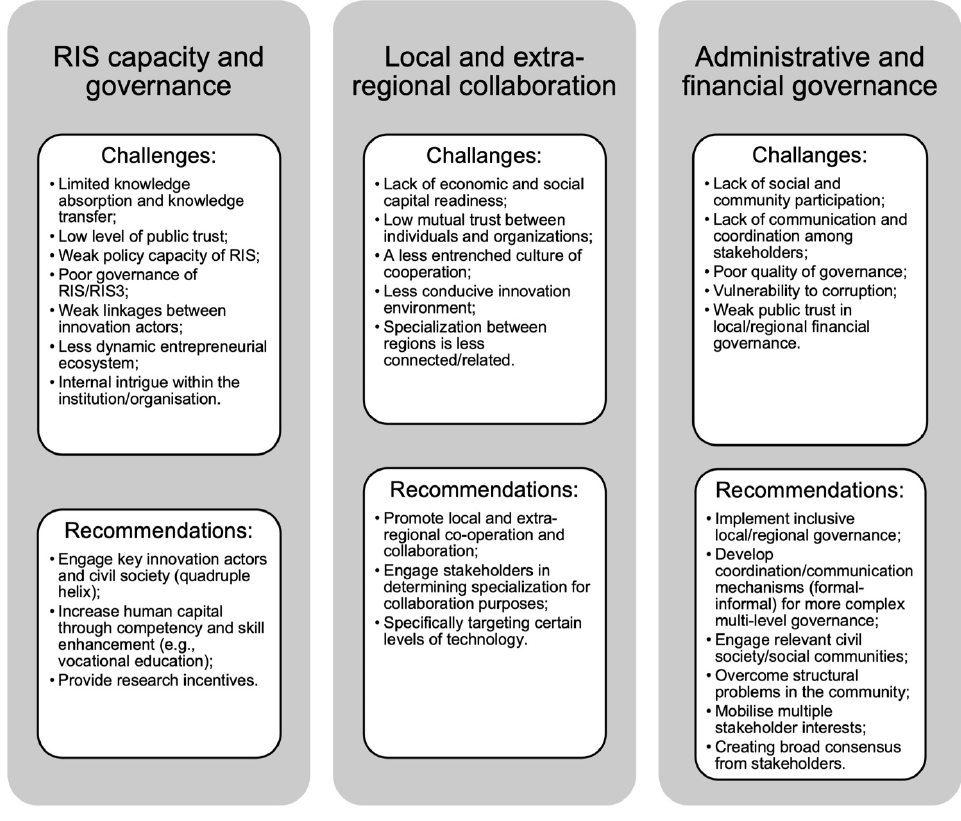
Figure 4: Key issues of S3 implementation in less-developed European